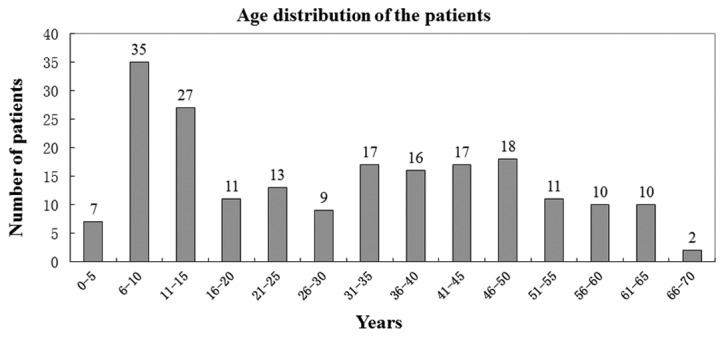
Age distribution of the patients.